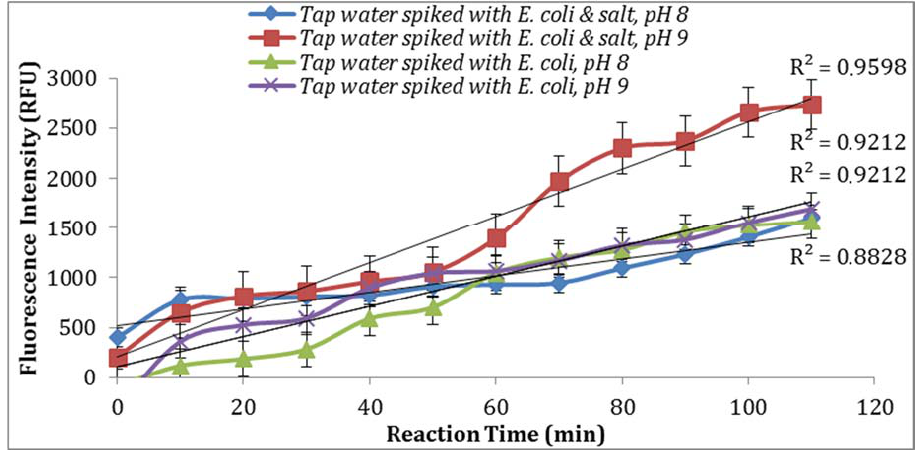
Figure 7. Effect of pH and salinity on the fluorescence signal in the biosensor assay. Note: Spiked water Figure 7 samples contained 1000 CFU/mL E. coli